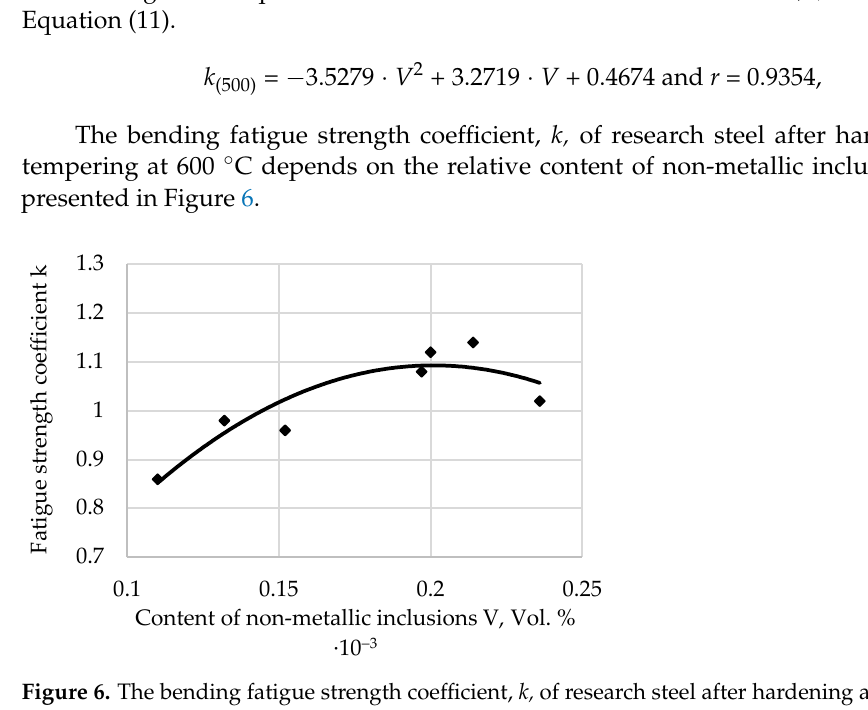
Figure 6. The bending fatigue strength coefficient, k, of research steel after hardening and tempering at 600 °C depends on the relative content of non-metallic inclusions.